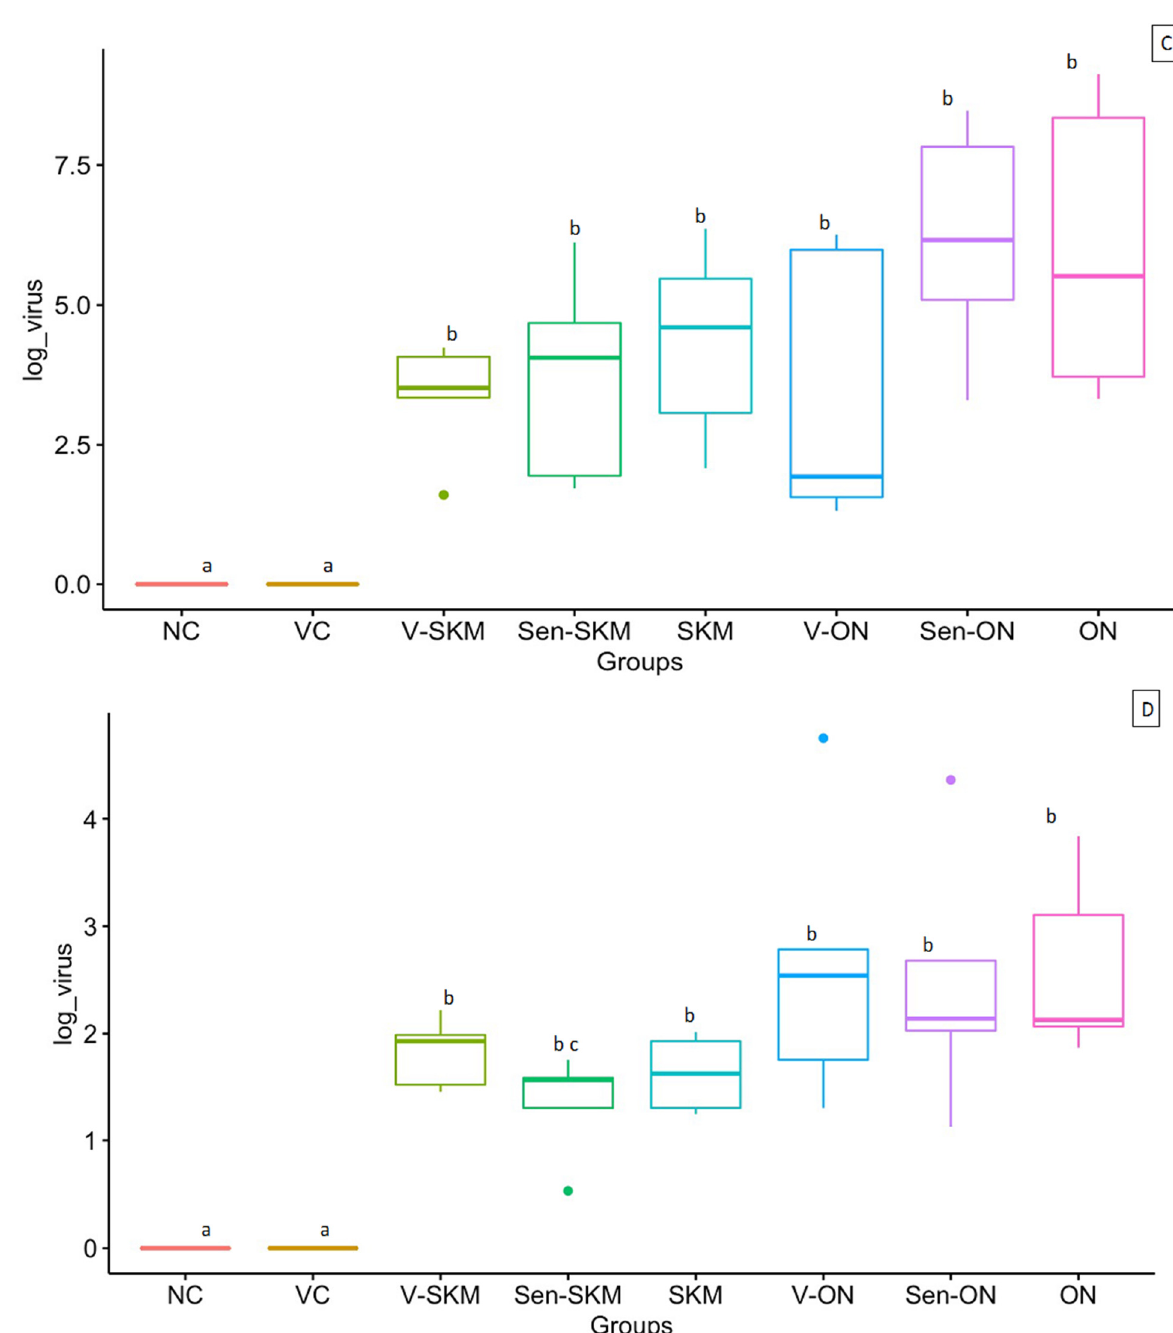
Figure 2. Virus gene copy numbers in birds from respective groups in ( A ) intestine at 21 doa; ( B ) intestine at 28 doa; ( C ) tendons at 21 doa; ( D ) tendons at 35 doa. Box plots with different letters have significant differences at p < 0.05.